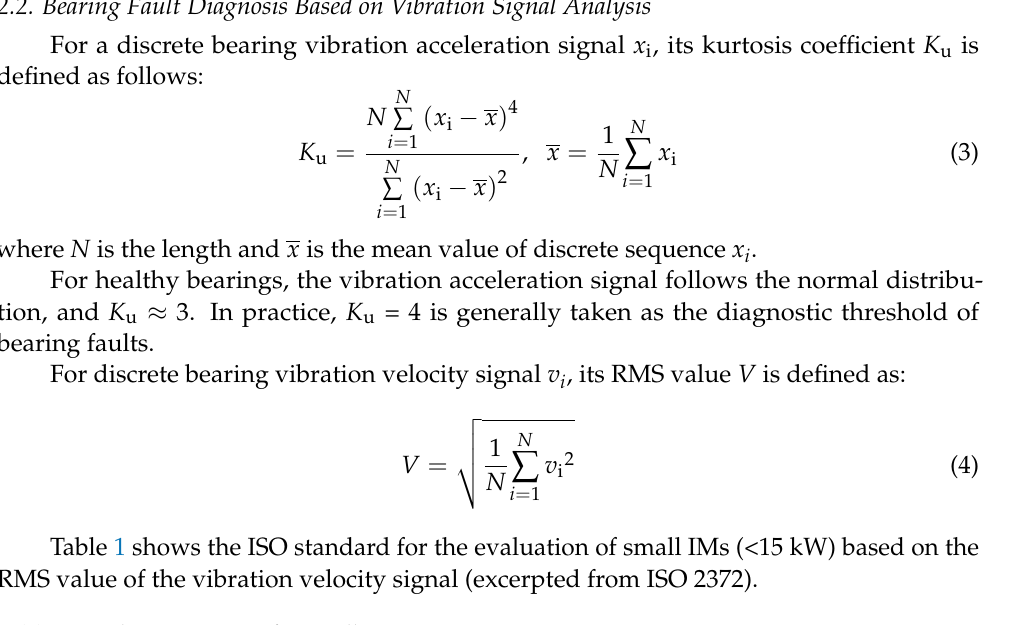
Table 1. Evaluation criteria for small